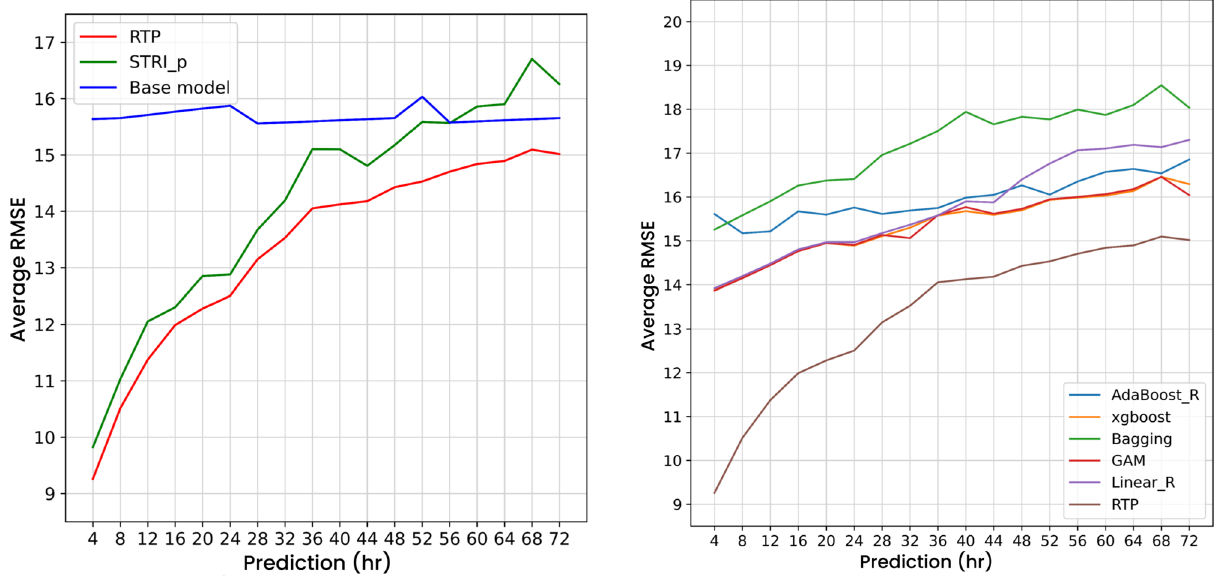
Figure 3. Left: average RMSE for RTP and its components. Right: average RMSE of RTP and other ensemble